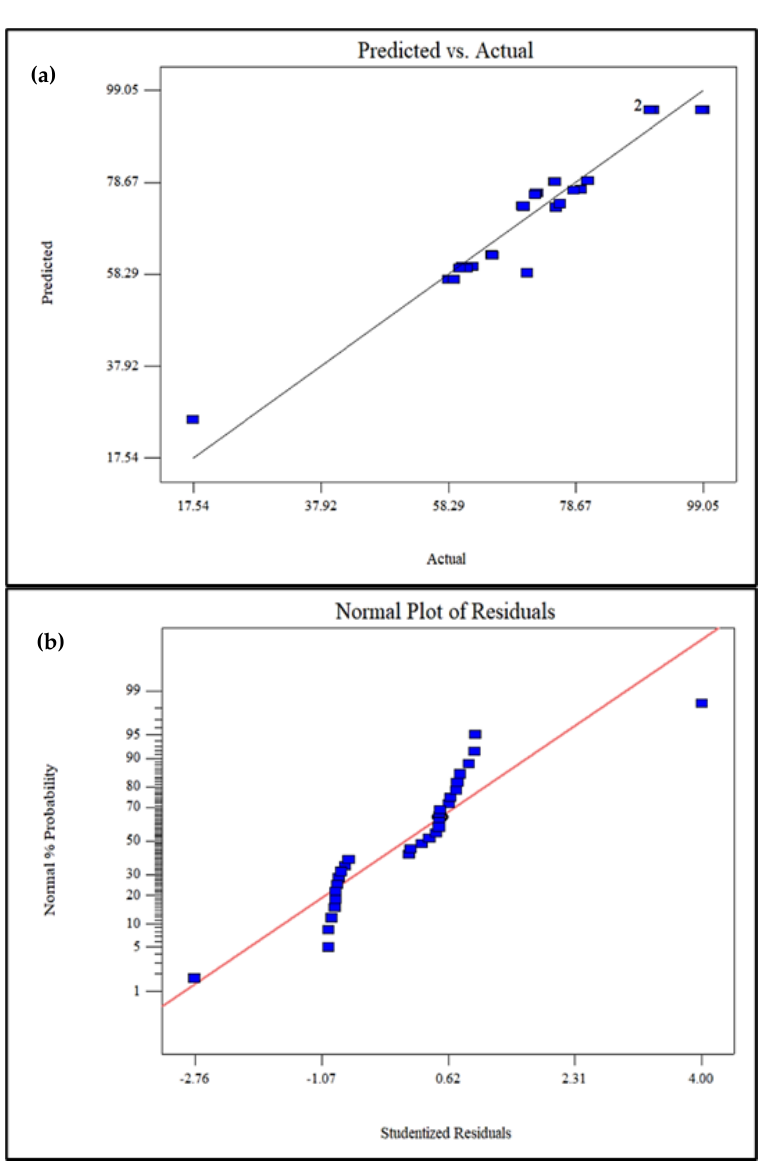
Figure 1. Diagnostic plots of the central composite design model of phenol degradation by the binary consortium. ( a ) Similarity plot between predicted and actual values for phenol degradation; ( b ) Normal probability plot against residuals for phenol degradation.